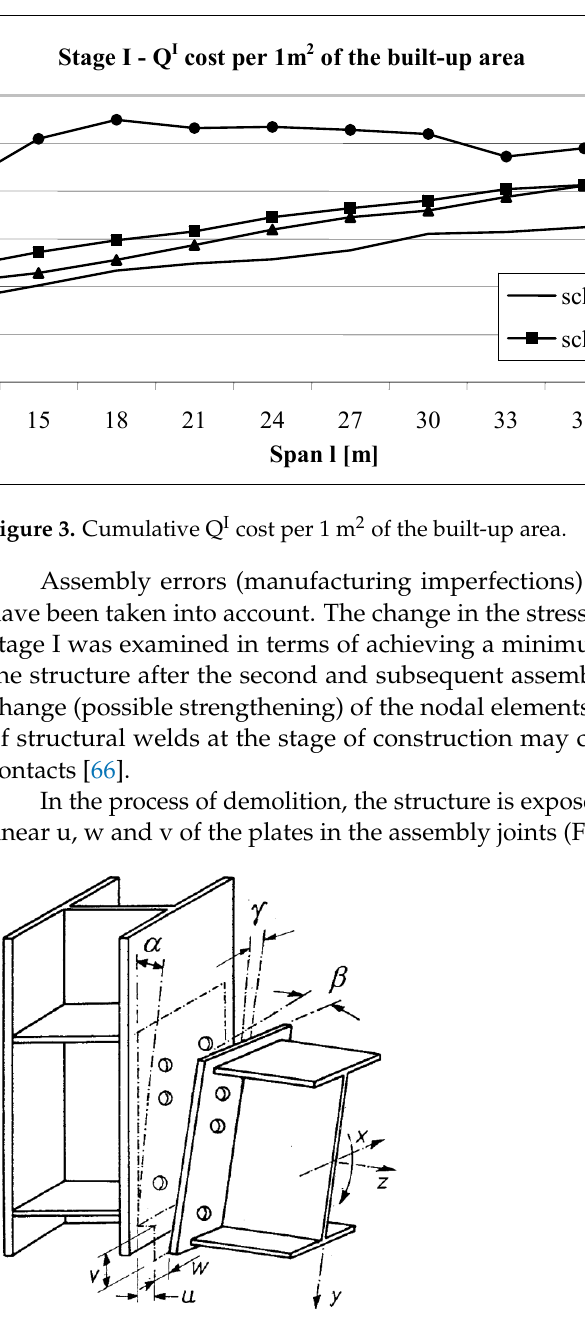
Figure 4. Scheme of imperfections of angular and linear butt contacts